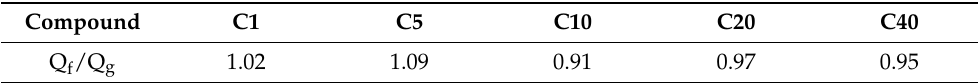
Table 5. Rubber-filler interaction (Q f /Q g